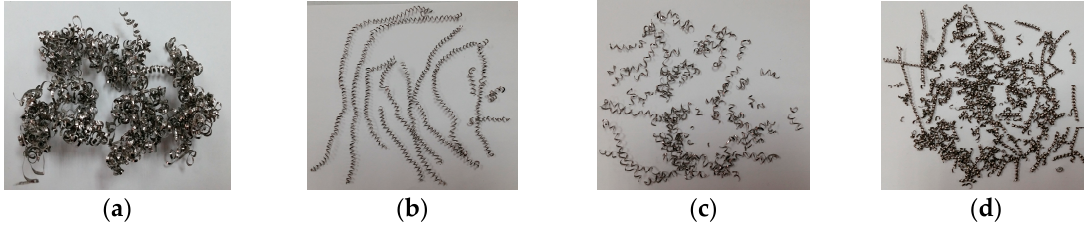
Figure 20. Evolution of the breakage of the chip with the increase of the feed rate (cutting speed of 50 m/min, depth of cut of 1.0 mm): ( a ) feed rate of 0.05 mm/r; ( b ) feed rate of 0.1 mm/r; ( c ) feed rate of 0.15 mm/r; and ( d ) feed rate of 0.2 mm/r.